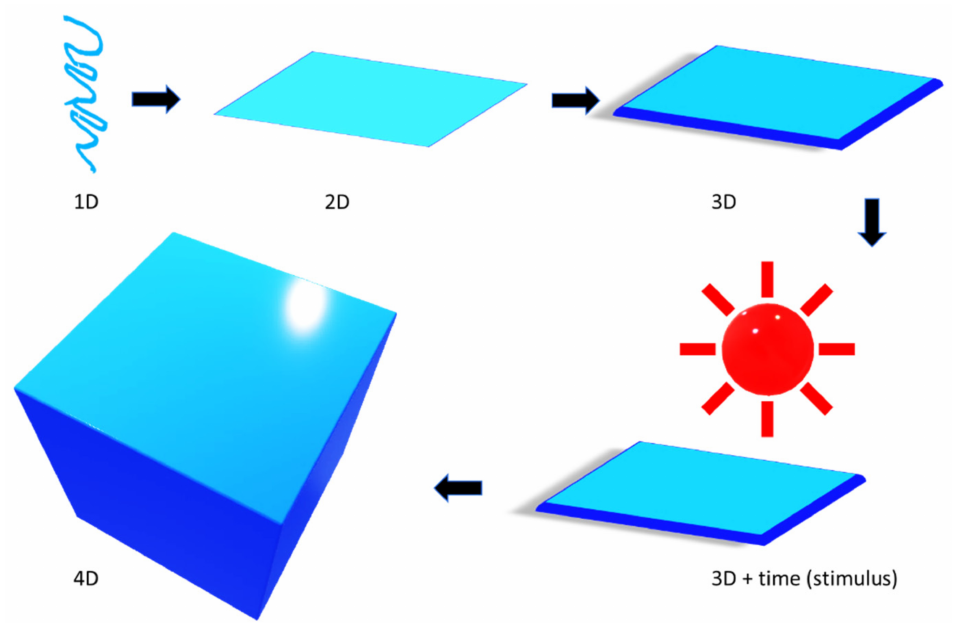
Figure 5. A simplified illustration of the concept of 4D